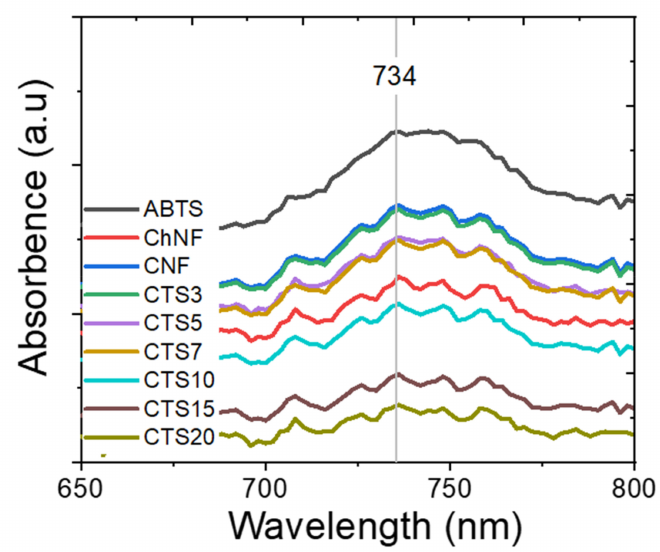
Figure 11. Antioxidant of ChNF–CNF